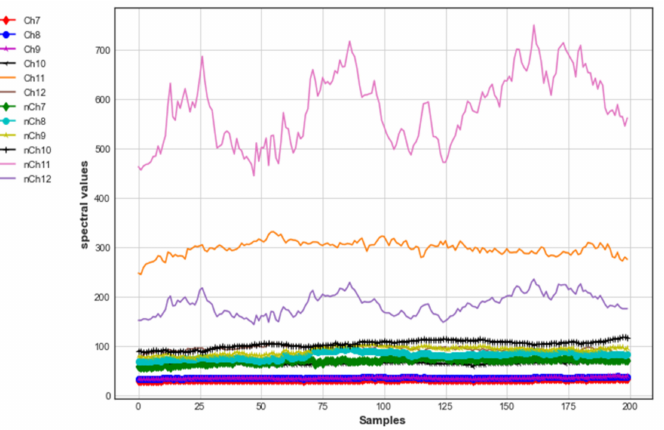
Figure 8. NIR-VIS (560–705 nm) photon count response of organic and conventional brinjal samples.